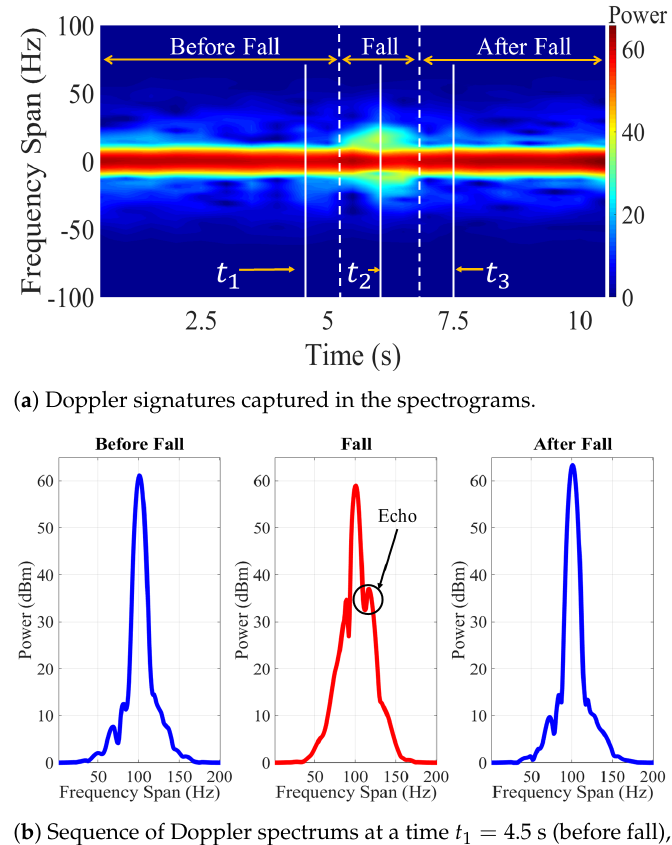
Figure 9. Experimental results using HH scenario setup: ( a ) spectrogram, ( b ) sequence of